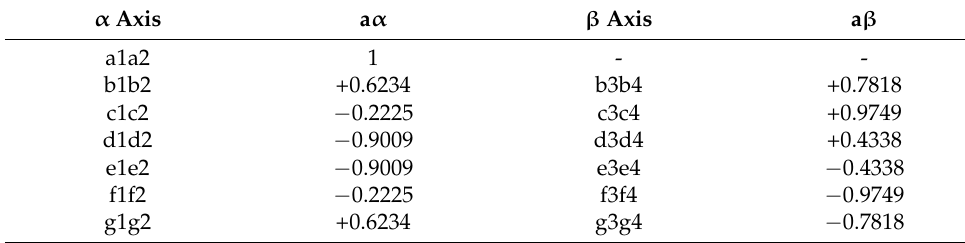
Table 4. Turn ratios of different